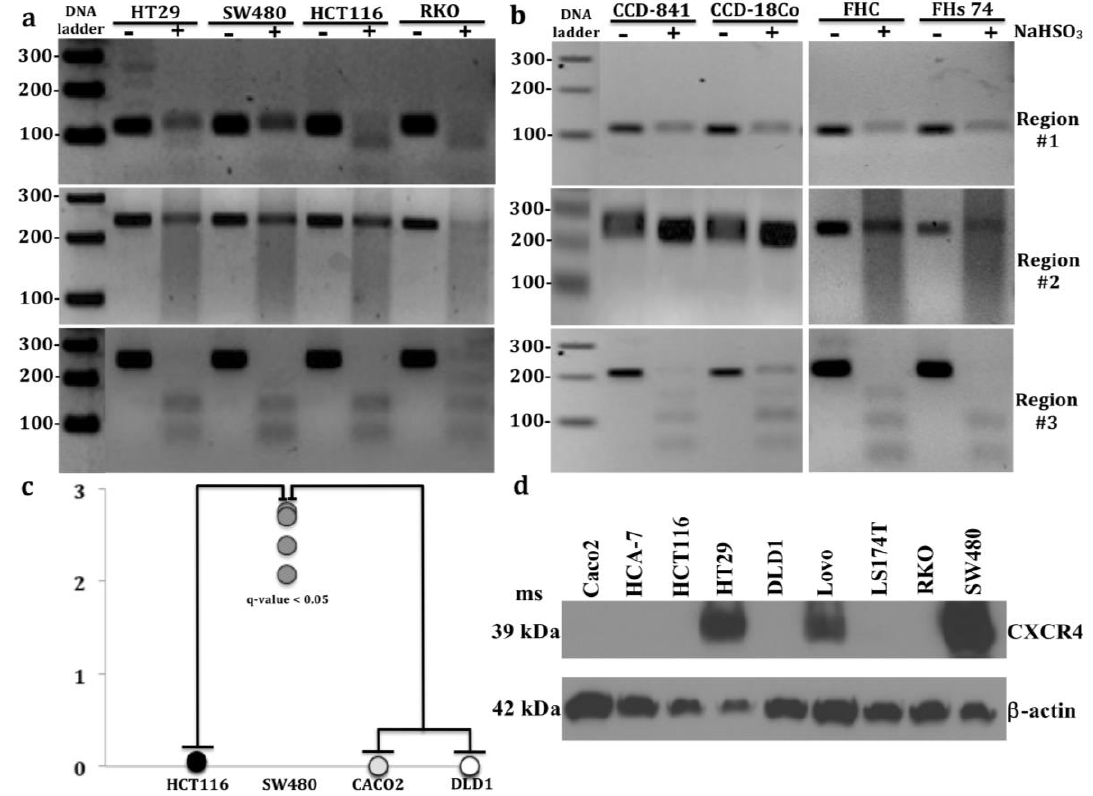
Figure 4. Combined bisulfite restriction analysis (COBRA) results of 3 regions of interest located in CXCR4 from: ( a ) 4 CRC cell lines: HT29, SW480, HCT116, and RKO cells and ( b ) 4 untransformed colon cell lines: CCD-841, CCD-18Co, FHC, and FHs 74 cells. Region #3 shows complete PCR product digestion in CRC cell lines: HT29, SW480, and HCT116 cells and untransformed cell lines: FHC and FHs 74 cells, indicating that region #3 is fully methylated. Incomplete PCR product digestion in RKO cells and untransformed colon cell lines: CCD-841 and CCD-18Co cells indicate partial methylation in region #1. Incomplete PCR digestion was only evident in RKO cells in region #2 indicating partial methylation. 3 of 4 CRC cell lines: HT29, HCT116, and RKO cells displayed incomplete PCR digestion in region #1, whereas no PCR digestion was evident in any untransformed colon cell line cells. ( c ) RT-PCR analysis of CXCR4 transcript abundance in 4 CRC cell lines: HCT116, SW480, Caco2, and DLD1 cells ( q -value < 0.05) after multiple testing correction (Tukey post hoc test, Supplementary Table S1). Note the increase of CXCR4 transcripts in SW480 cells compared to HCT116, Caco2, and DLD1 cells. ( d ) Western blot analysis of CXCR4 in 9 CRC cell lines: Caco2, HCA-7, HCT116, HT29, DLD1, Lovo, LS174T, RKO, and SW480 cells (Supplementary Table S2). PCR product treated with restriction enzyme lane = + ; PCR product untreated lane = −